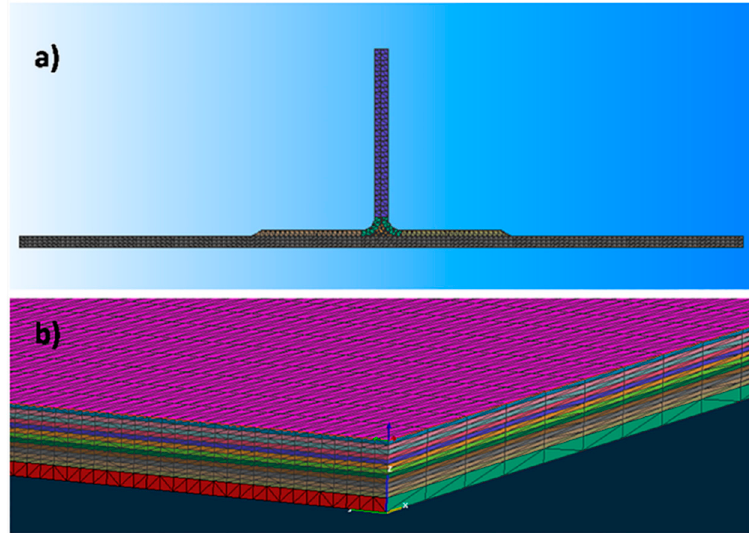
Figure 9. ( a ) Front view of the meshed component with the flat panel and the stringer, ( b ) meshed geometry of the base panel.